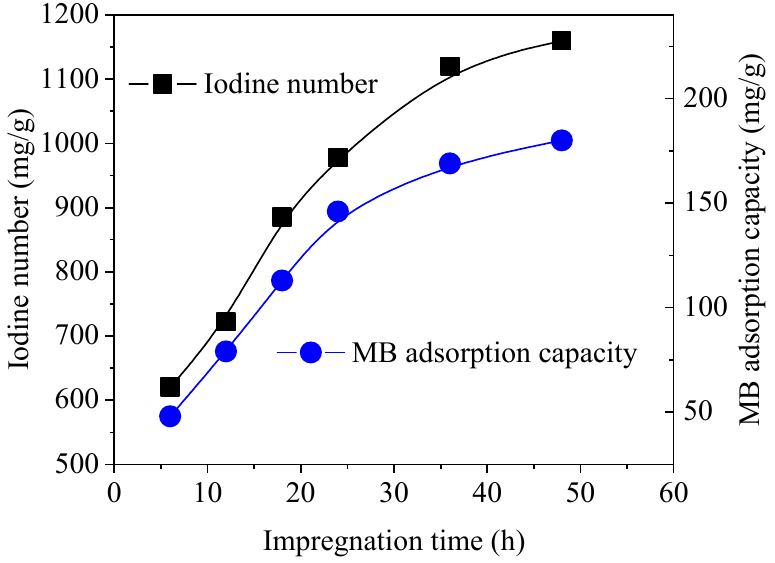
Figure 5. Effect of impregnation time on the adsorption performance of activated carbon by NaOH activation. Conditions: alkali carbon ratio 1.5:1 and activation temperature 650 °C.